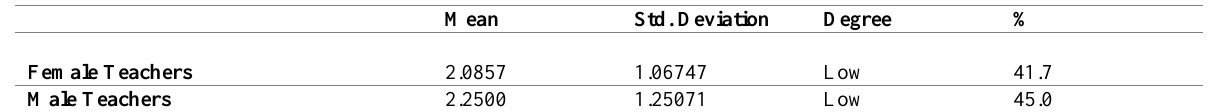
Table 2: Significance in Life